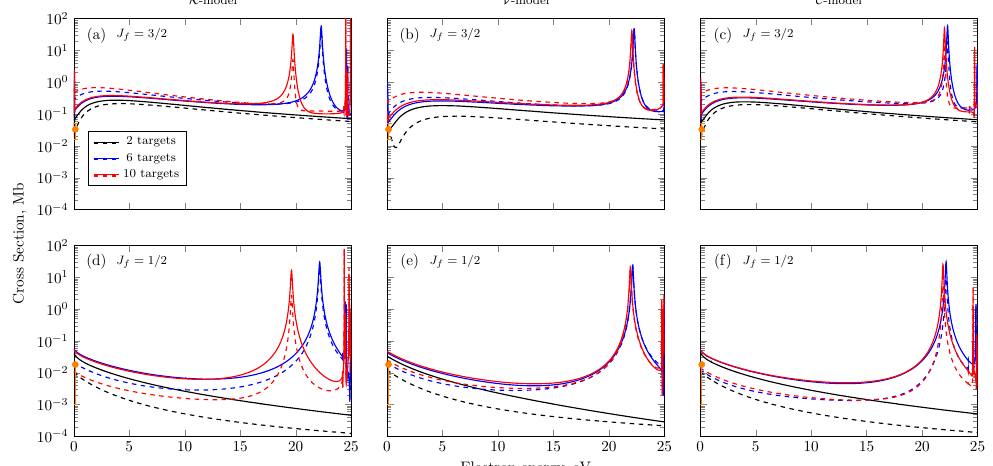
Figure 2. Photoionization cross-section of 2 s 2 2 p 5 ( 2 P 3/2 ) 3 s [ 3/2 ] 2 state of neon to 2 s 2 2 p 5 ( 2 P 3/2 ) (upper row) and 2 s 2 2 p 5 ( 2 P 1/2 ) (bottom row). Calculations are performed within R - ( a , d ), V - ( b , e ) and C -model ( c , f ). Solid lines are for calculations in the length gauge and dashed for the velocity gauge; different colors mark the number of accounted targets: two (black), six (blue) and ten (red). Experimental data points are taken from [38] and labeled by